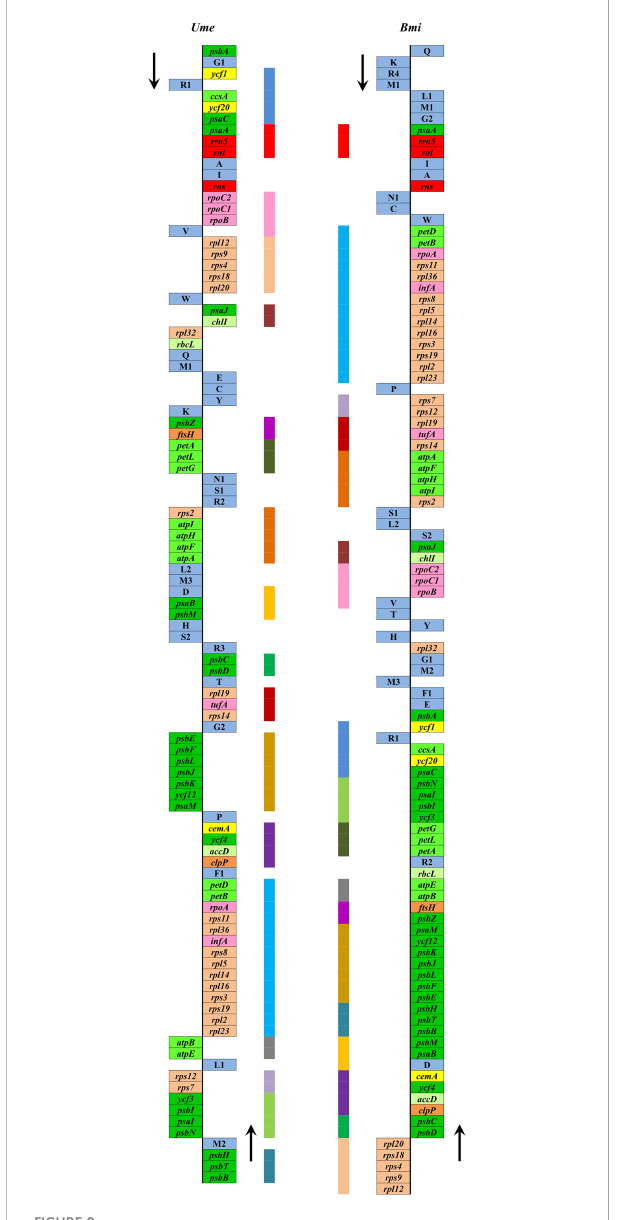
FIGURE 9 Comparison of plastome organization and gene order between Ulva meridionalis (OP985133) and Blidingia minima (MK408749 and MT948112). Thick lines with different colors between two plastomes represented different gene blocks. The arrows indicated the direction of gene transcription. Only canonical genes were shown as fi lled boxes in different colors representing different gene